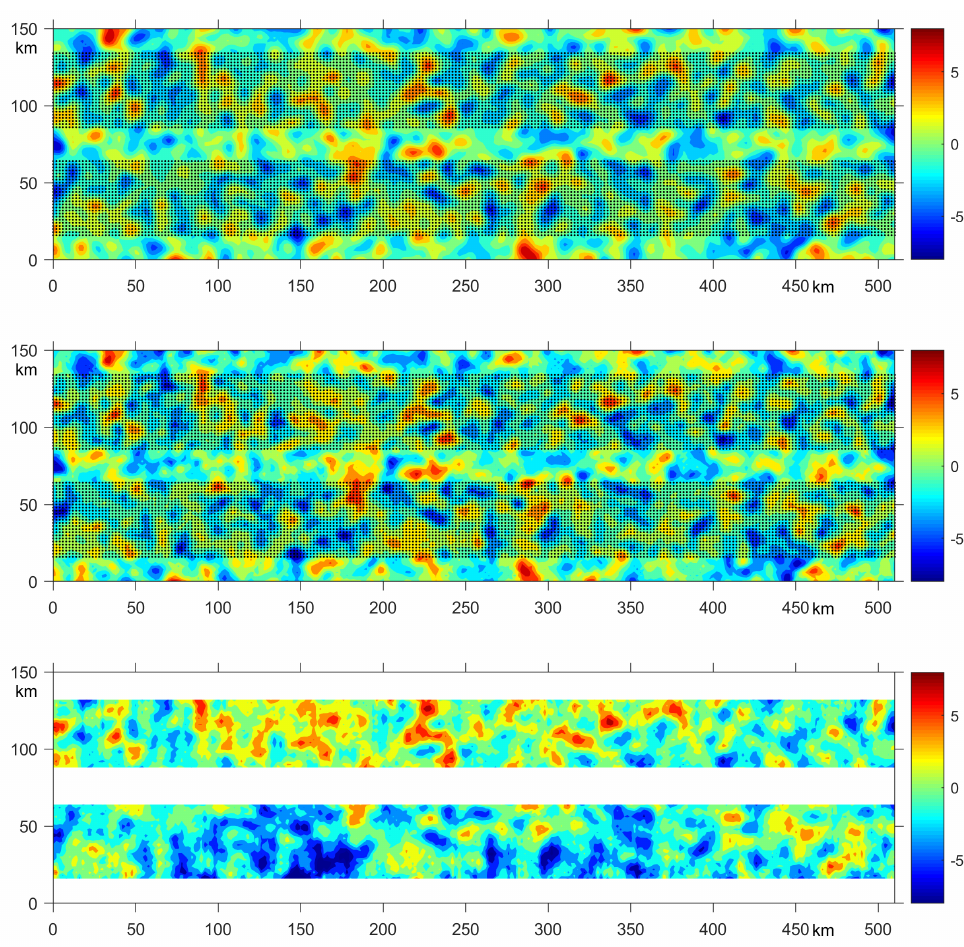
Figure 3. The true (being reconstructed) SSH field ( top ), and random realizations of the model background ( middle ) and observed ( bottom ) fields. Locations of the simulated SWOT observations are shown by black dots. SSH values are in